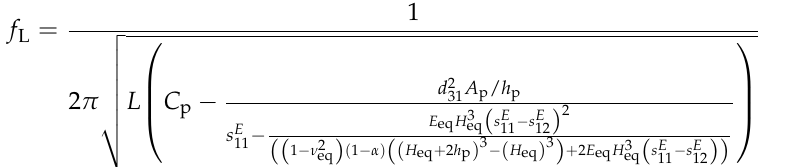
Figure 12. Comparison of theoretical numerical results and FE simulation results. ( a ) Numerical calculations compared to Comsol results. ( b ) STL curve [26,32] under the same conditions.